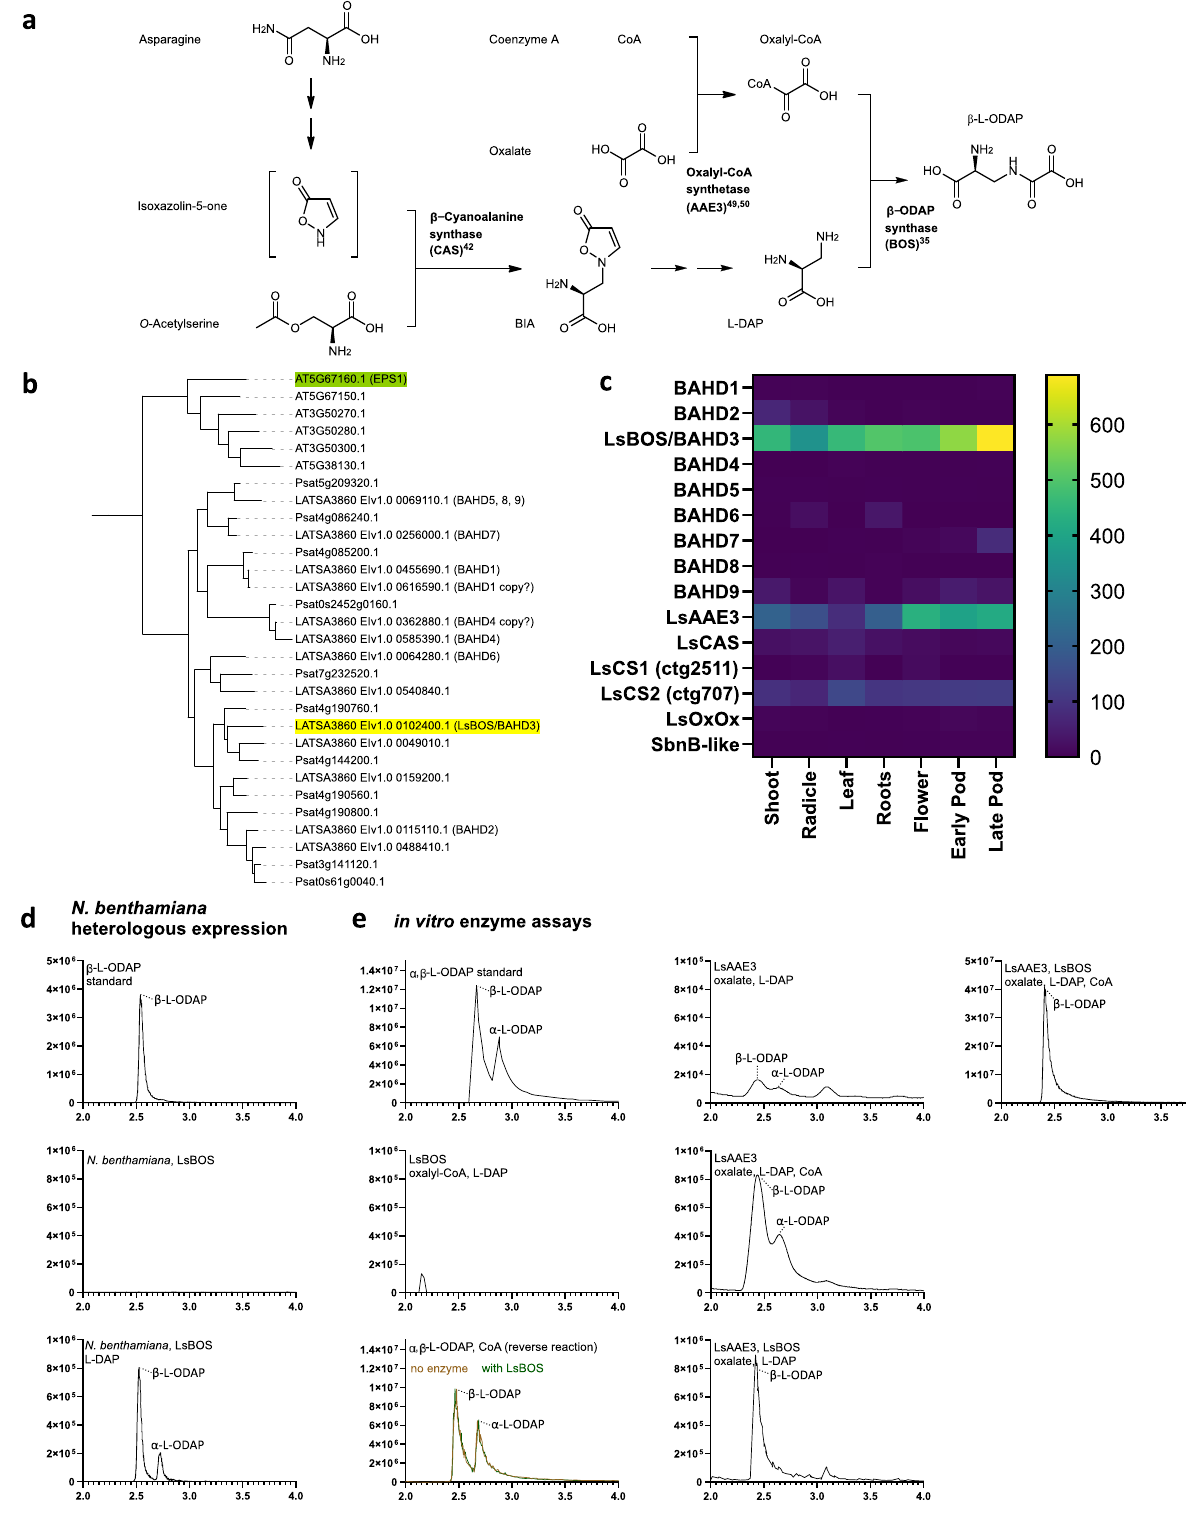
Fig. 3 | Identi fi cation and in vitro con fi rmation of LsBOS. a Grass pea β -L-ODAP biosynthesis as reviewed by Yan et al. 44 b Clade including EPS1 and LsBOS (high- lighted) from the maximum likelihood phylogeny of BAHD-ATs of A. thaliana , P. sativum and L. sativus (full phylogeny shown in Supplementary Data 1). c Heatmap transcript abundance of genes of interest in L. sativus (in TPM). d LCMS spectra